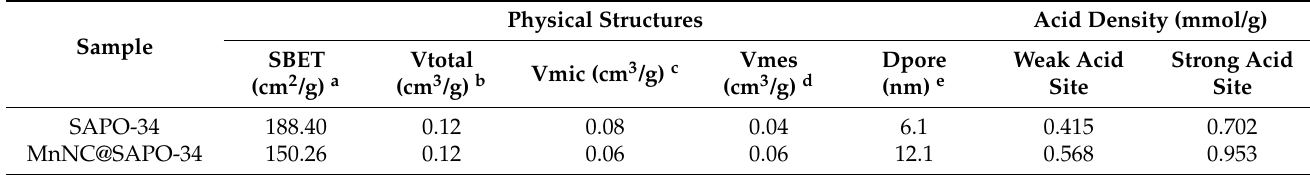
Table 1. Physical property and acid density of SAPO-34 silicoaluminaphosphates and MnNC@SAPO-34 composites.